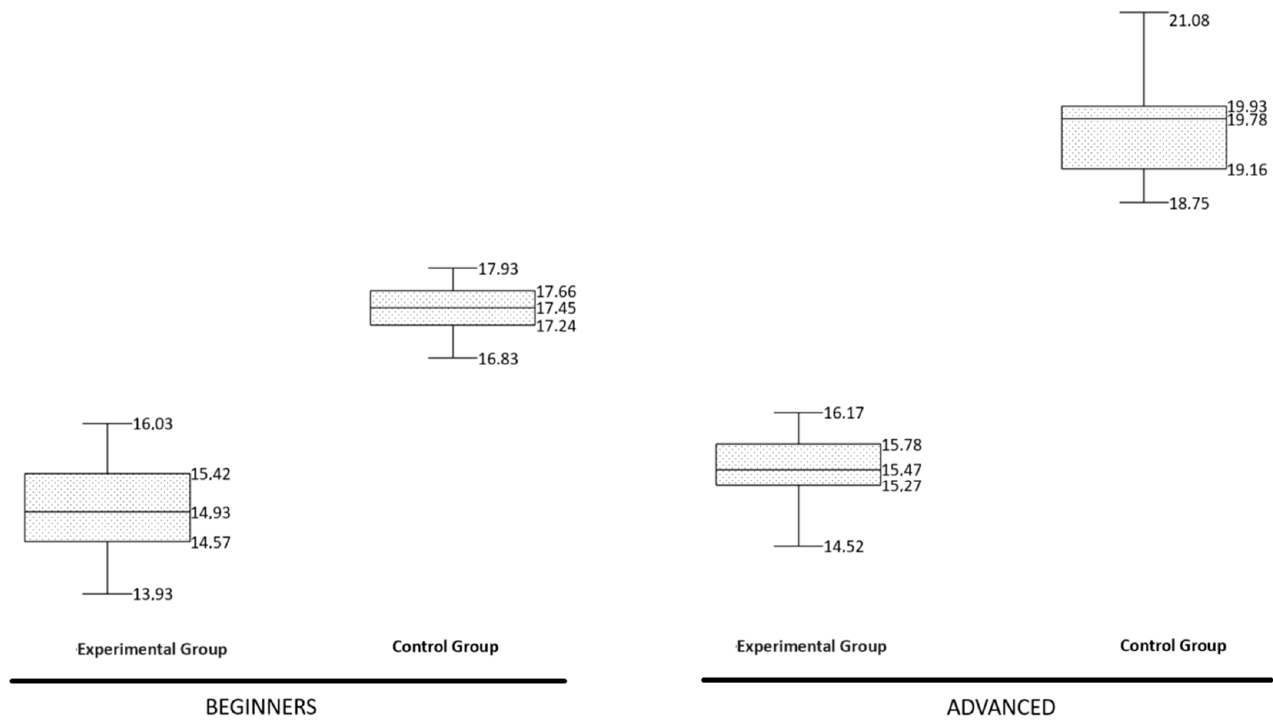
Figure 9. Time of each participant of the beginners and advanced group to solve the questionnaire.